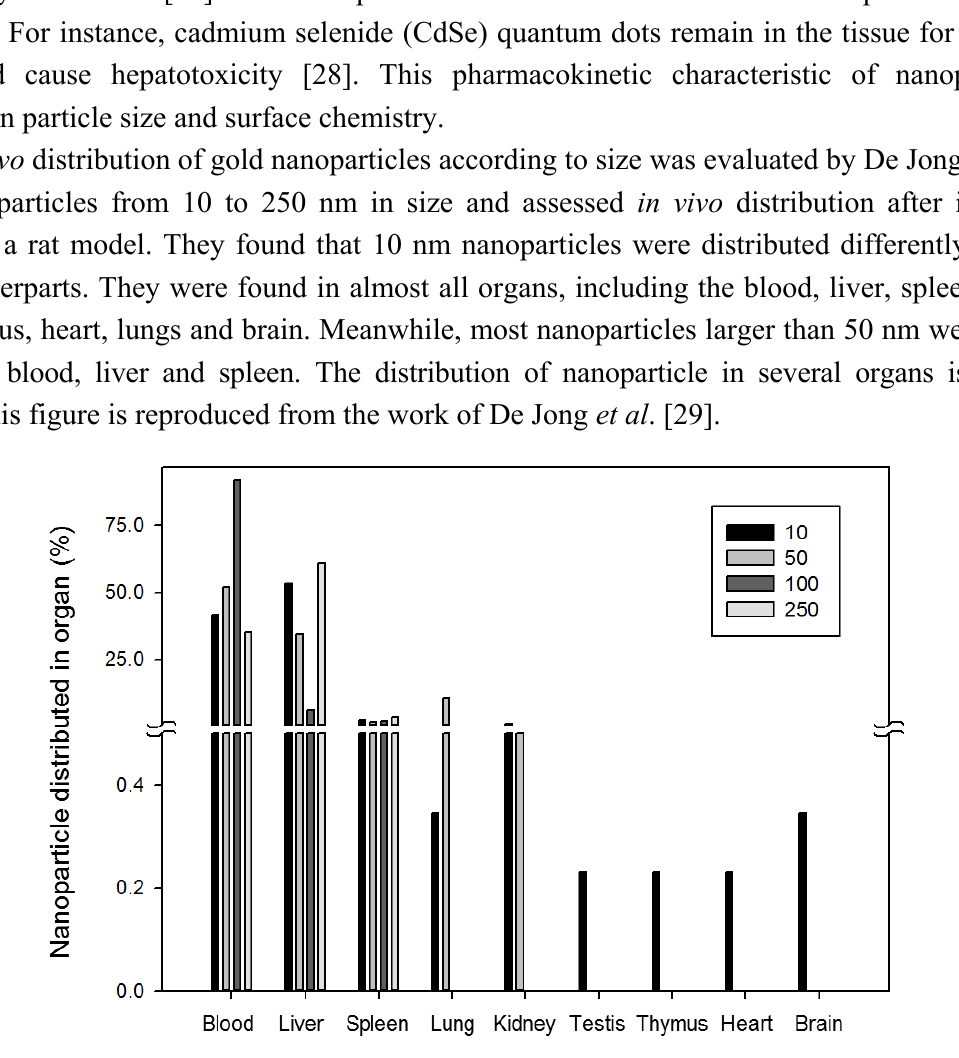
Figure 3. Gold nanoparticle distribution in several organs in rat according to particle size